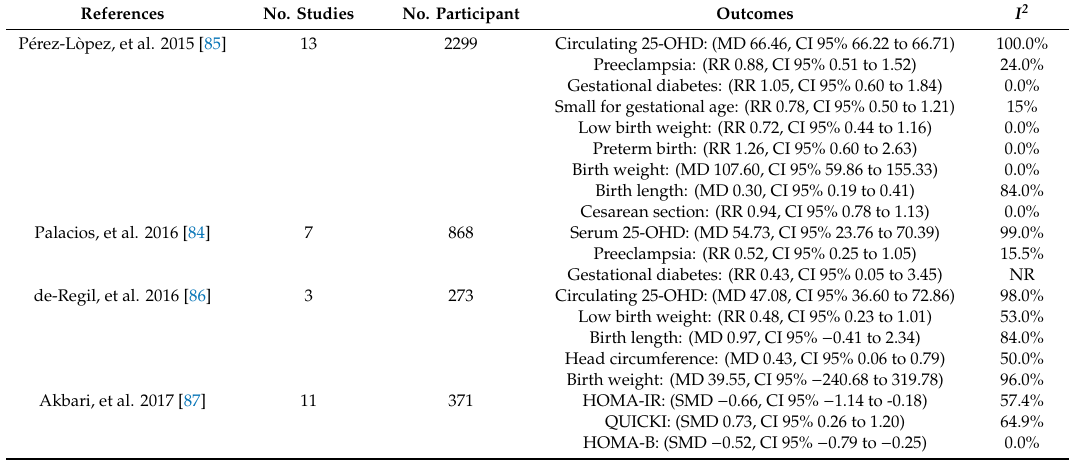
Table 2. Association between intervention with vitamin D and GDM outcomes in meta-analyses of